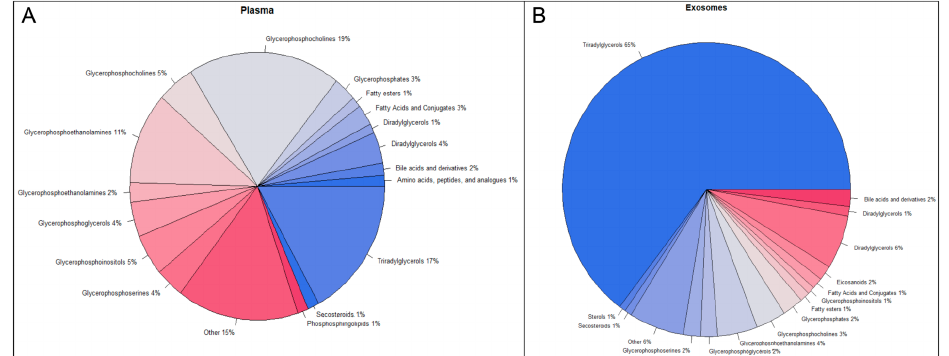
Figure 4. Compound profiles of exosomes and plasma based off accurate mass database search. All significant m / z ’s for both plasma and plasma-derived exosomes were subjected to accurate mass database search through CEU-MassMediator, the Human Metabolome Database (HMDB) and Metlin. Potential identities for each m / z were screened for their biological relevance. Class for each potential identification was then pulled from the respective database and graphed as a pie chart to help visualize potential metabolite and lipid profile differences between ( A ) plasma and ( B )